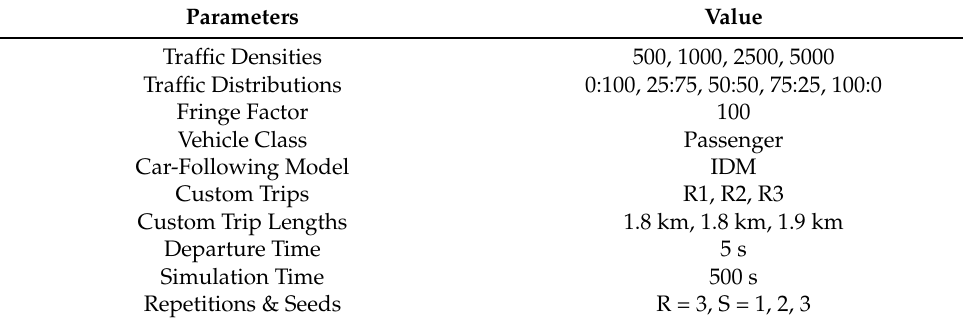
Table 3. Simulation